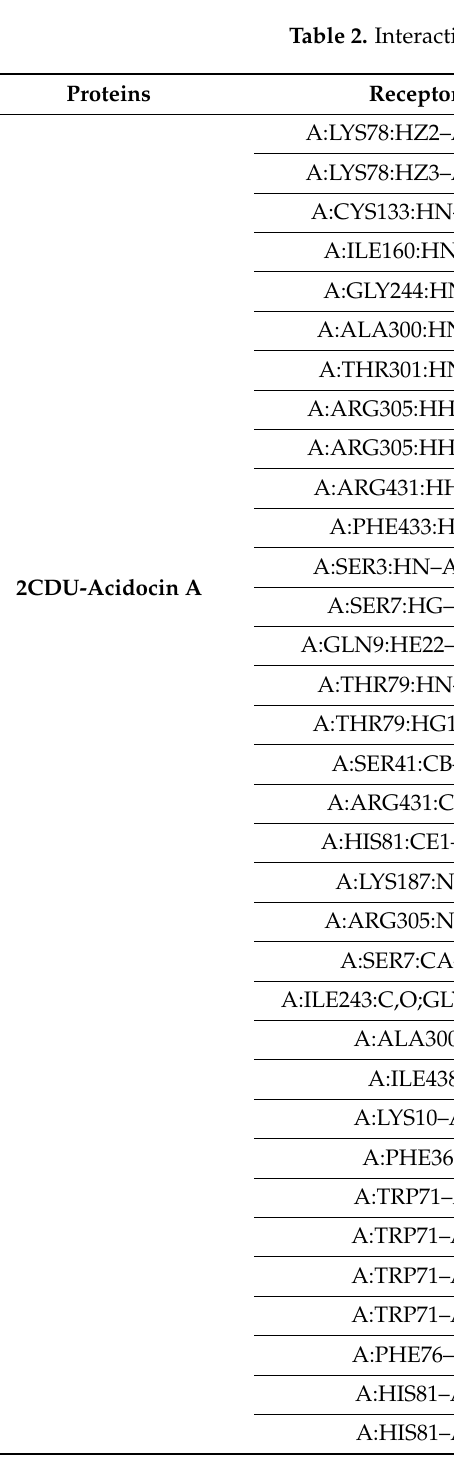
2CDU-Acidocin A